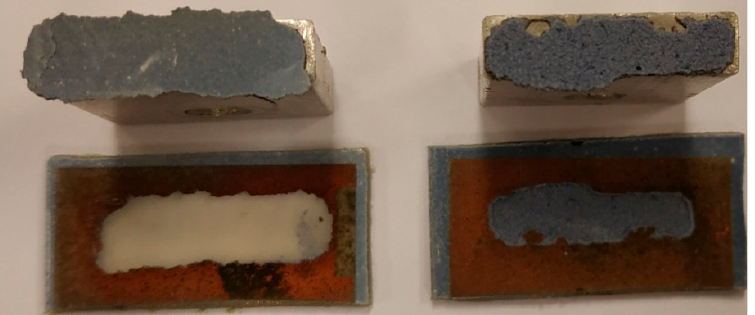
Figure 9. Sample photos of metallized coatings with compound B and stamps after the pull off